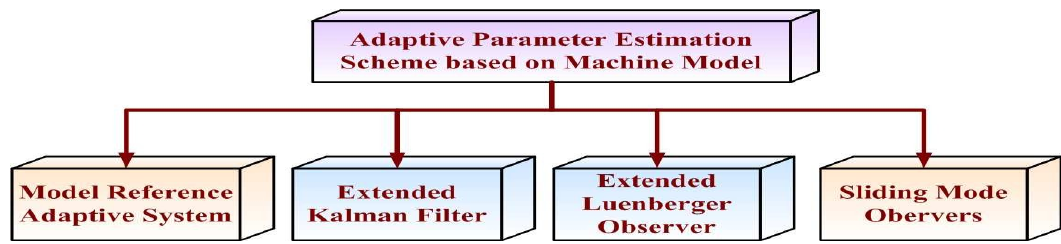
Figure 1. Machine model based adaptive parameter estimation schemes .